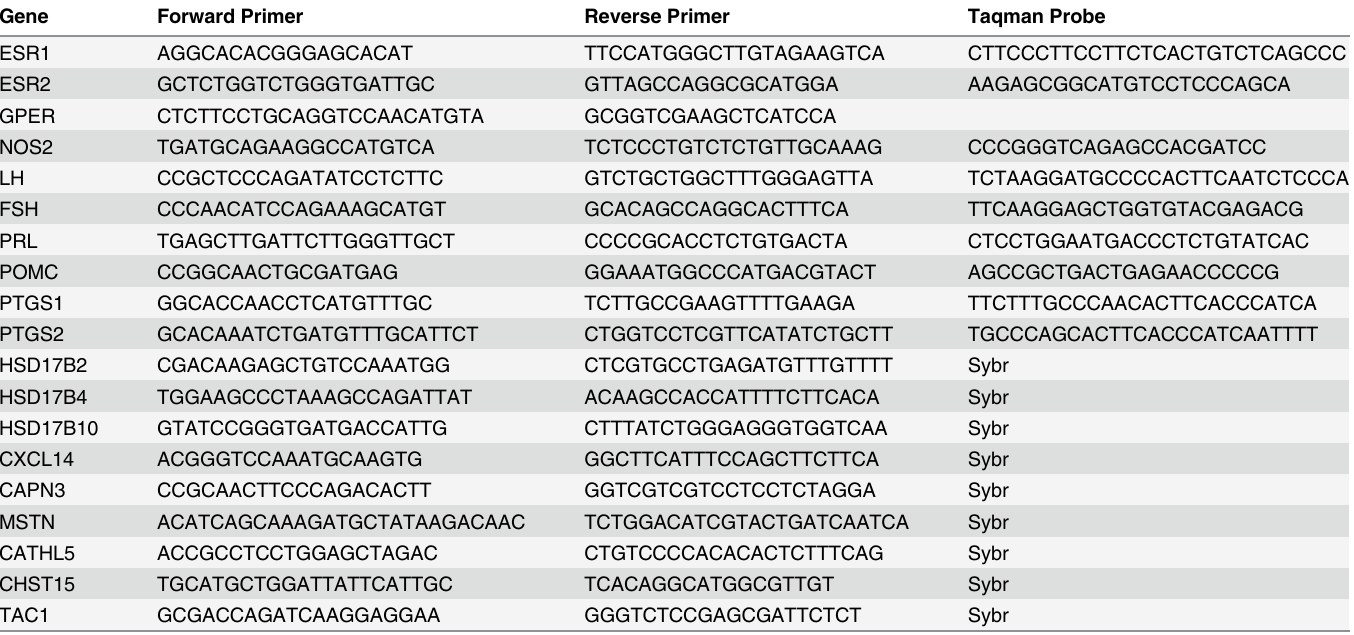
Table 7. Primer and probes used in qPCR